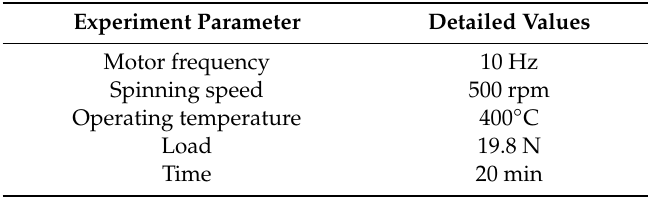
Table 4. The detailed parameter of the friction and wear